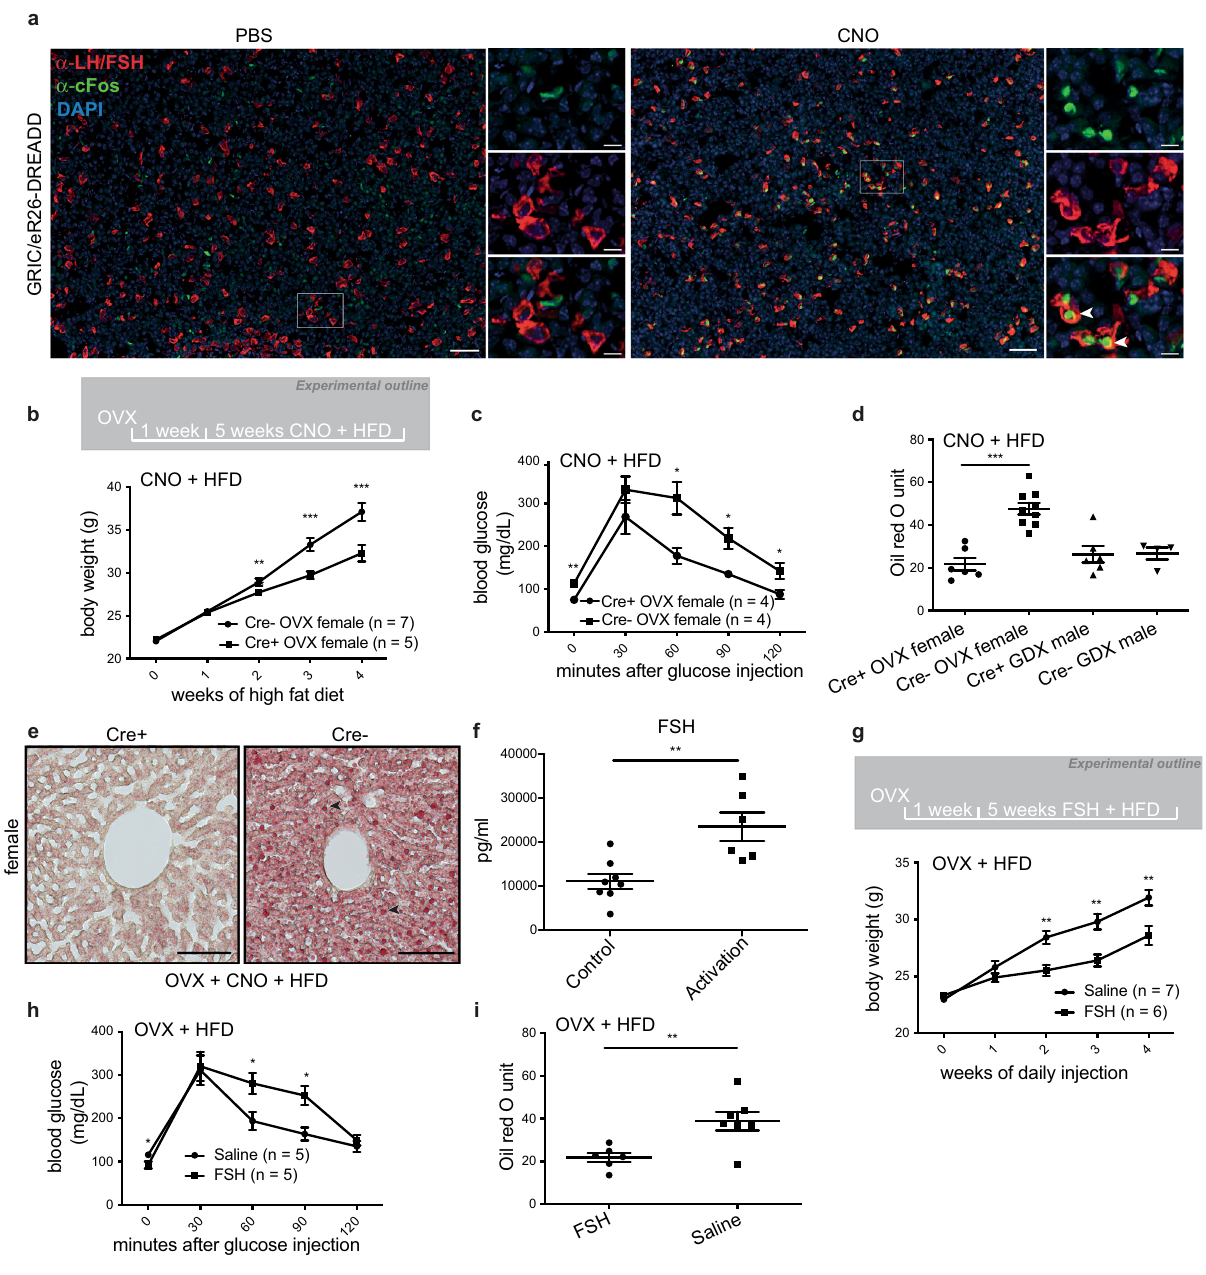
Fig. 4 | Gonadotrope activation or FSH administration is suf fi cient to improve metabolic disorders including hepatic steatosis in female mice. a RepresentativeimagesofpituitariesfromPBS(left)andclozapine-N-oxide(right) i.p.injectedGRIC/eR26-DREADDmice.TheexpressionofcFos(showningreen)was used as a marker for cellular activation. Gonadotropes are shown in red, corre- sponding to the expression of LH and FSH. DAPI is shown in blue (scale bars=50 μ m in full-size images, 20 μ m in insets, and fi lled arrowheads indicate activated gonadotropes.). b Body weight, c glucose tolerance, d liver oil red O staining quanti fi cation, and e representative images (scale bars=100 μ m, fi lled arrowheads